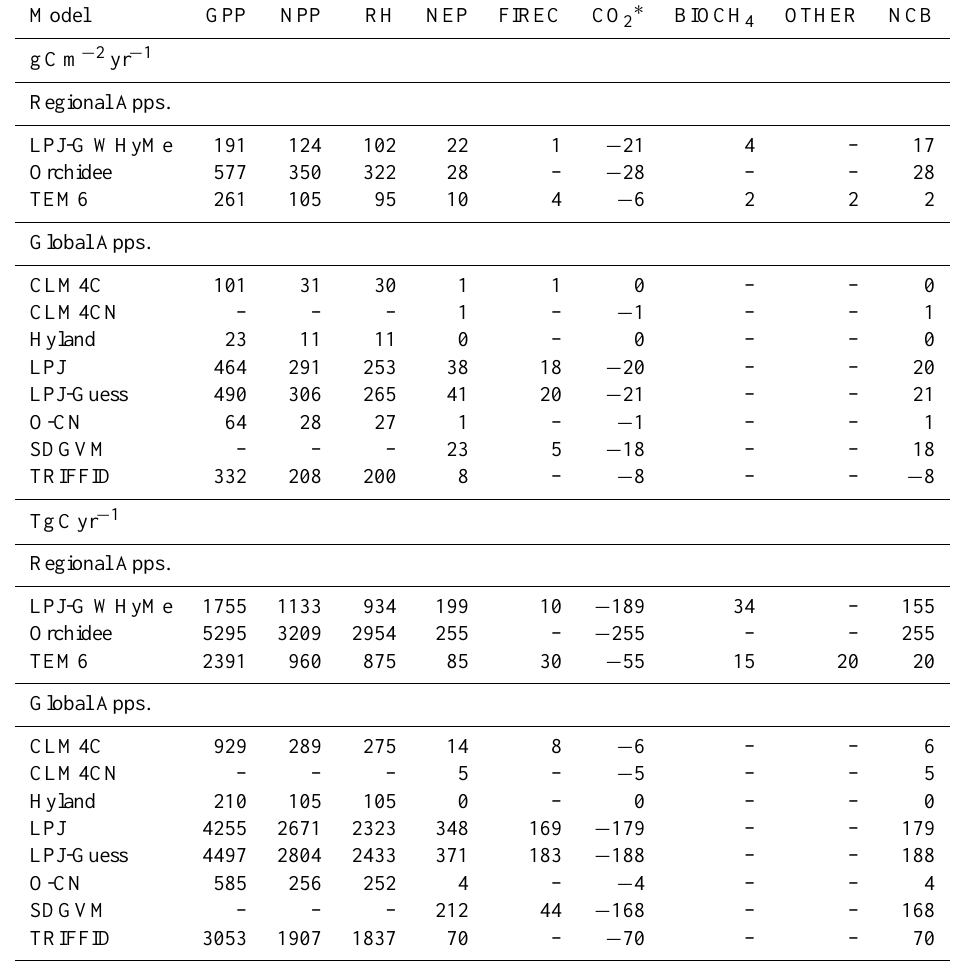
Table 5. Mean C budget of Arctic tundra simulated by process models for 1990–1999.